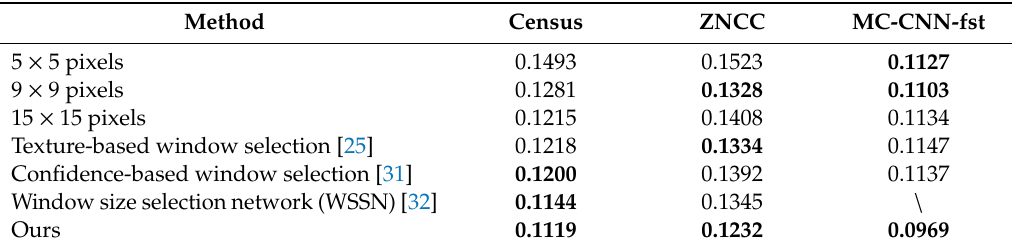
Table 2. Mismatch-3 comparison of seven di ff erent methods on the aerial dataset (bold records indicate the top-three optimal results among each of the considered matching cost